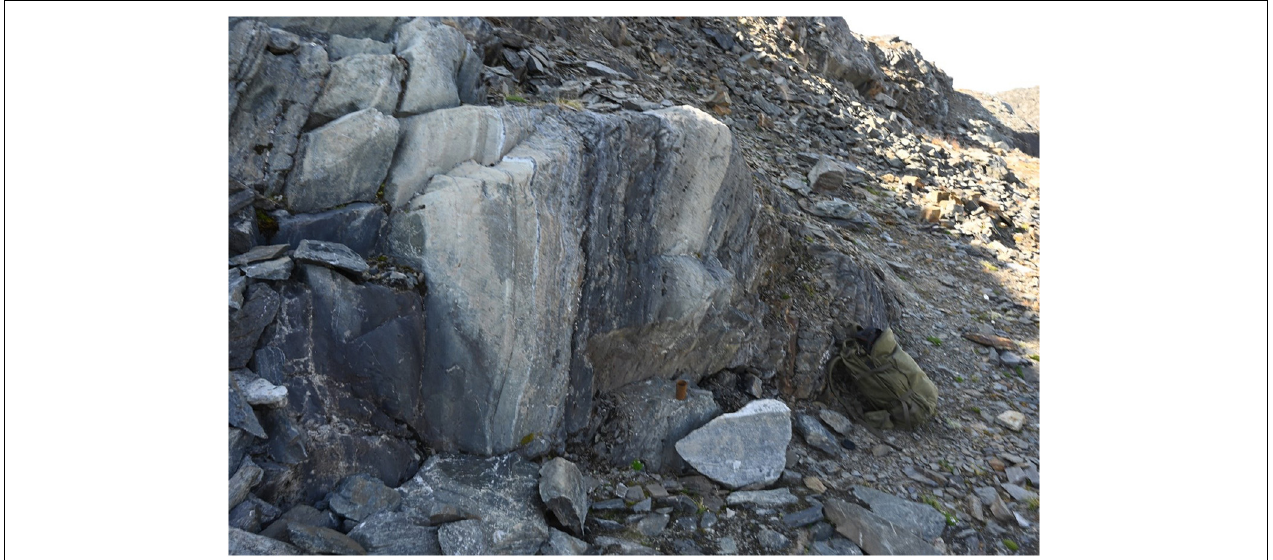
FIGURE 2 | Photo of the main outcrop of the turbidite locality from which the studied samples were taken, which is the same locality that was documented by Rosing (1999). The graphitic slate is the obvious dark layer in the middle, with the proposed meta-turbidites on either side of it displaying gradational lamination. This outcrop is a protected site, and hence the samples for this study are from the continuation of the strata a couple of meters above and behind this rock face. Backpack for